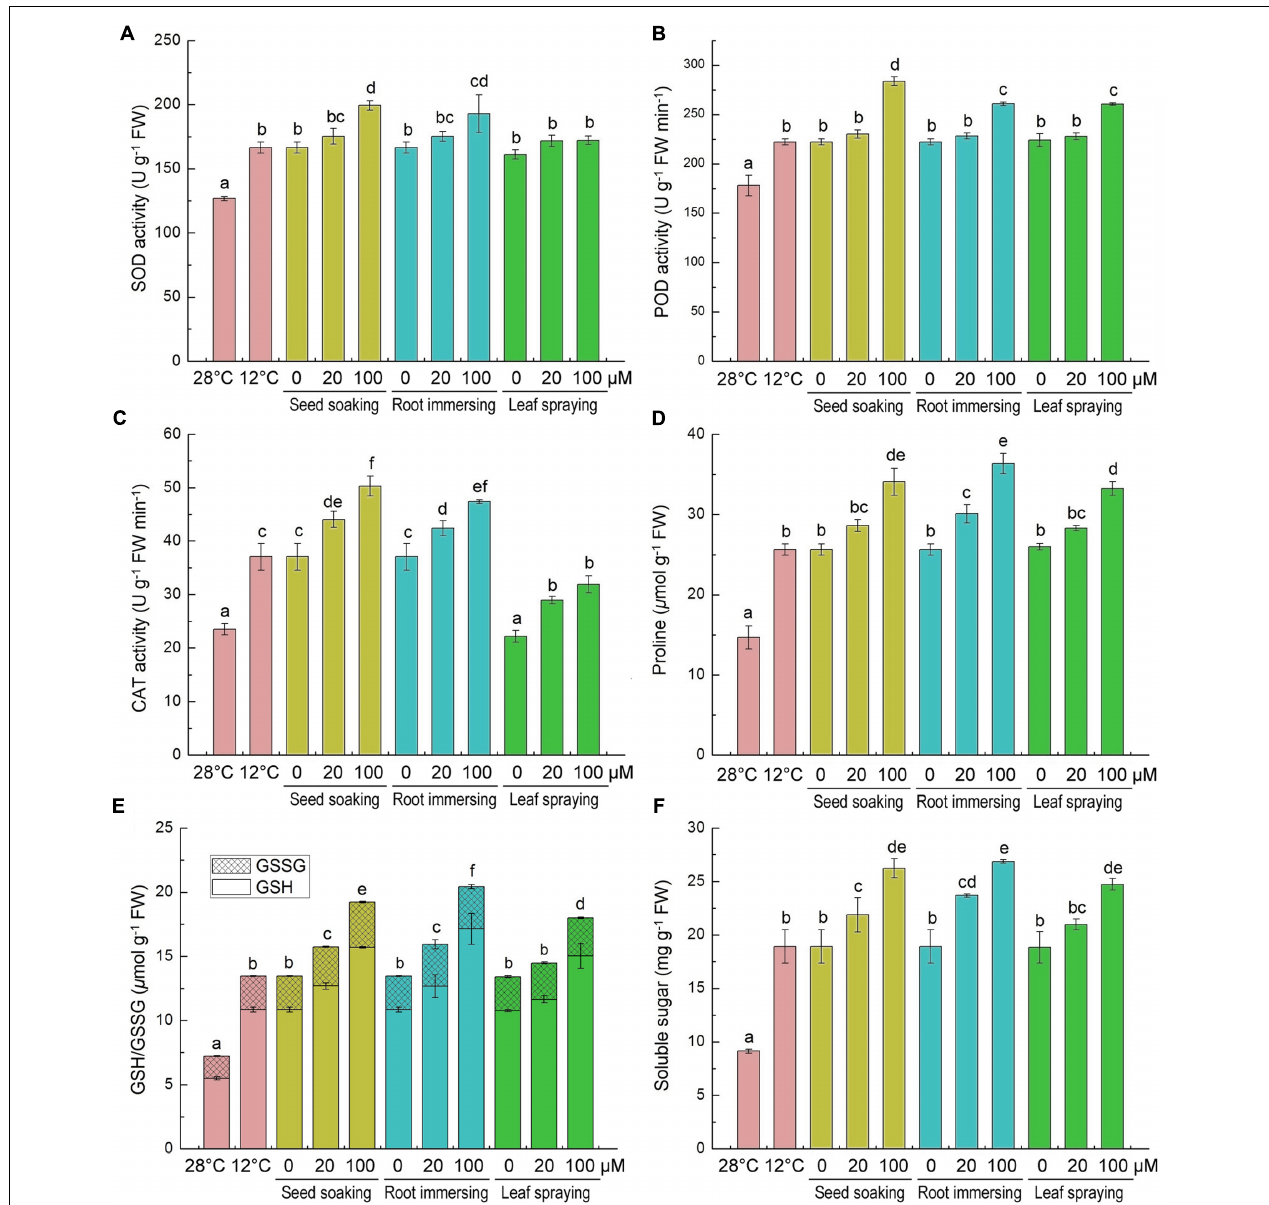
FIGURE 5 | Effects of exogenous melatonin on SOD activity (A) , POD activity (B) , CAT activity (C) , proline content (D) , GSH content (E) , and soluble sugar content (F) after 6-day cold stress (12 ◦ C). Others are the same as in Figure 1